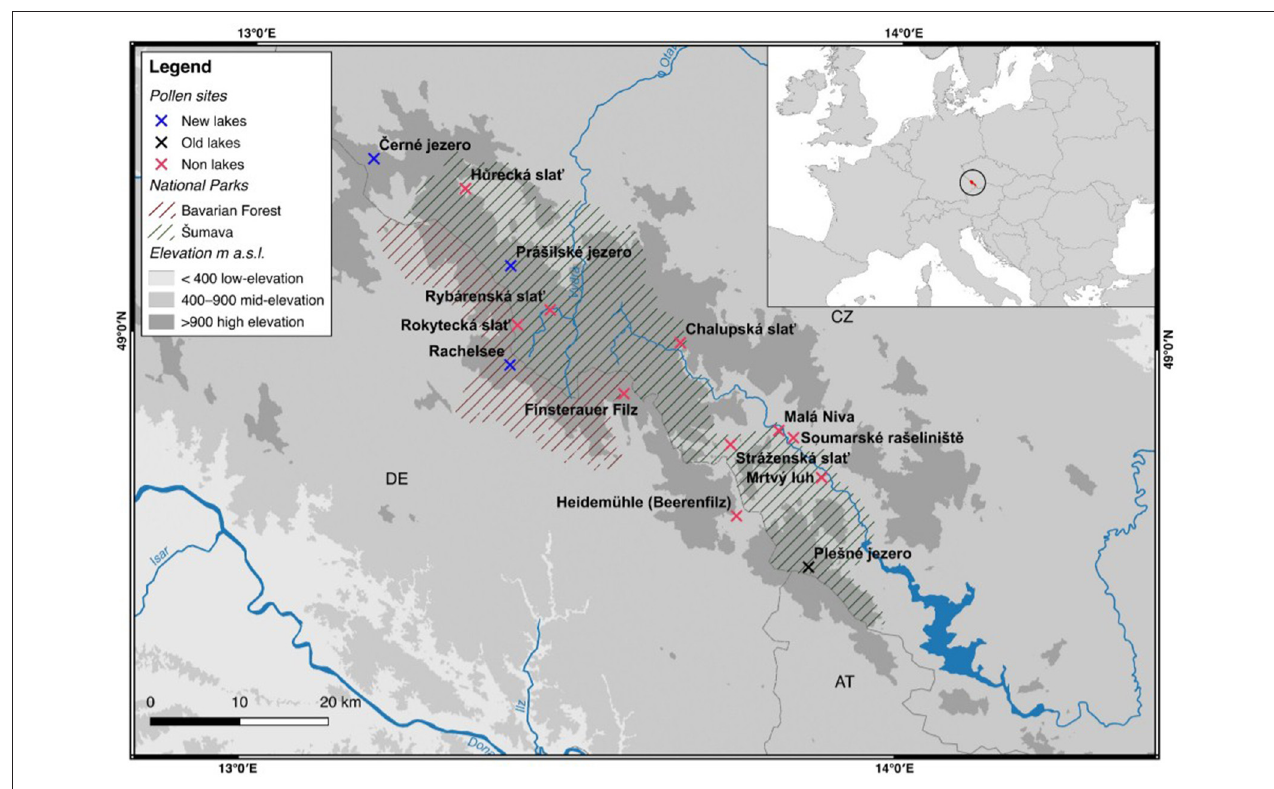
FIGURE 1 | Site map of the Bohemian/Bavarian Forest region of central Europe. Non-lakes (i.e., bogs and/or forest mires) are indicated by a red cross. Newly analyzed lakes presented in this study are indicated by a blue cross. Previously published lakes are indicated by a black cross. The National Park boundaries are indicated by green (Šumava) and red (Bavarian Forest) solid